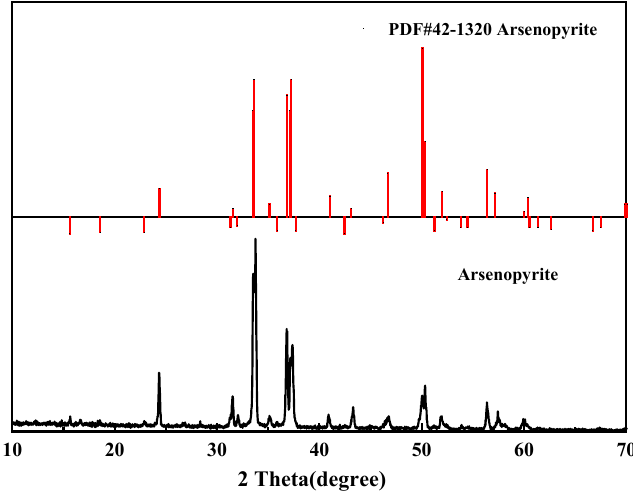
Figure 1. X-ray diffraction patterns of arsenopyrite with corresponding PDF cards.